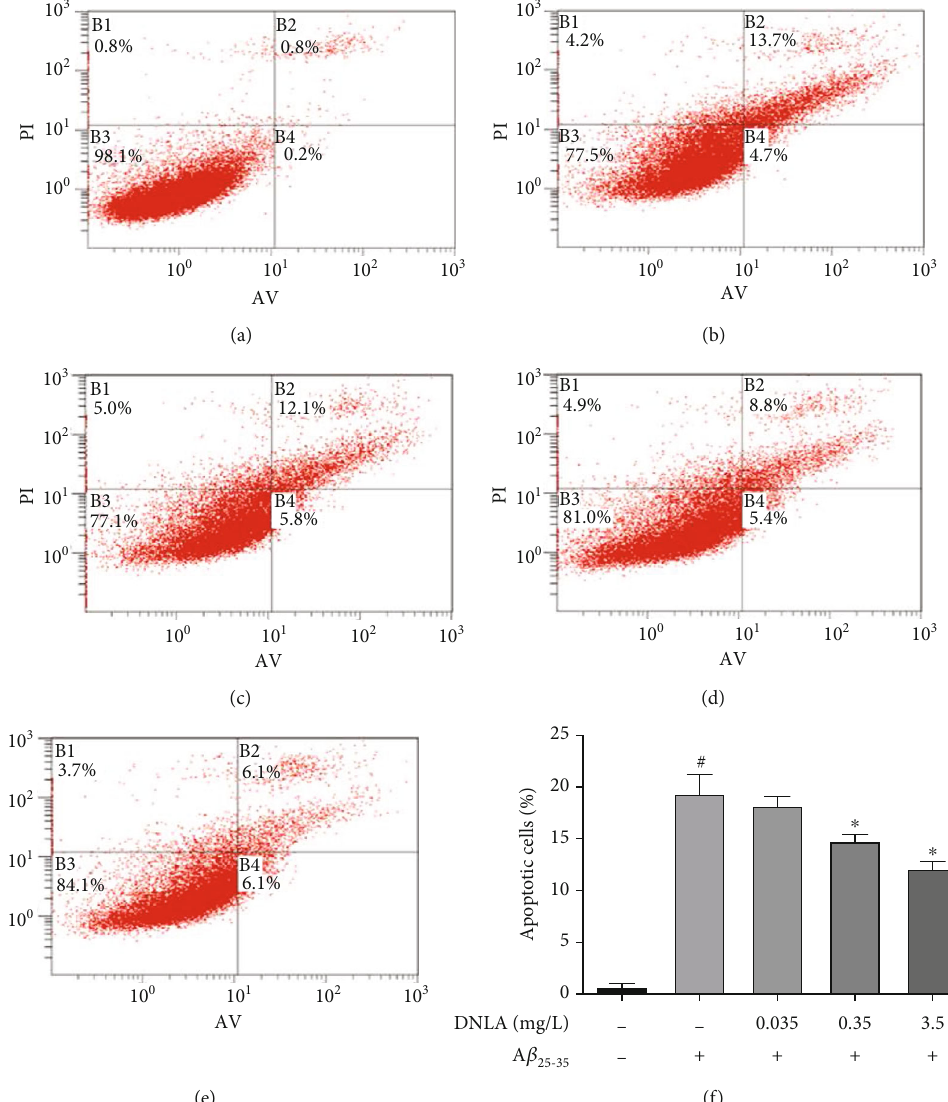
Figure 3: E ff ect of DNLA on PC12 cell apoptosis induced by A β . (a – e) Flow cytometry detection of Annexin V-FITC/PI staining to 25-35 detect apoptotic cells in control, model, DNLA-L, DNLA-M, and DNLA-H groups, respectively. (f) The number of the apoptosis cells ( n = 3 , (cid:1) x ± s ). Note: # P < 0 : 05 vs. control; ∗ P < 0 : 05 vs.